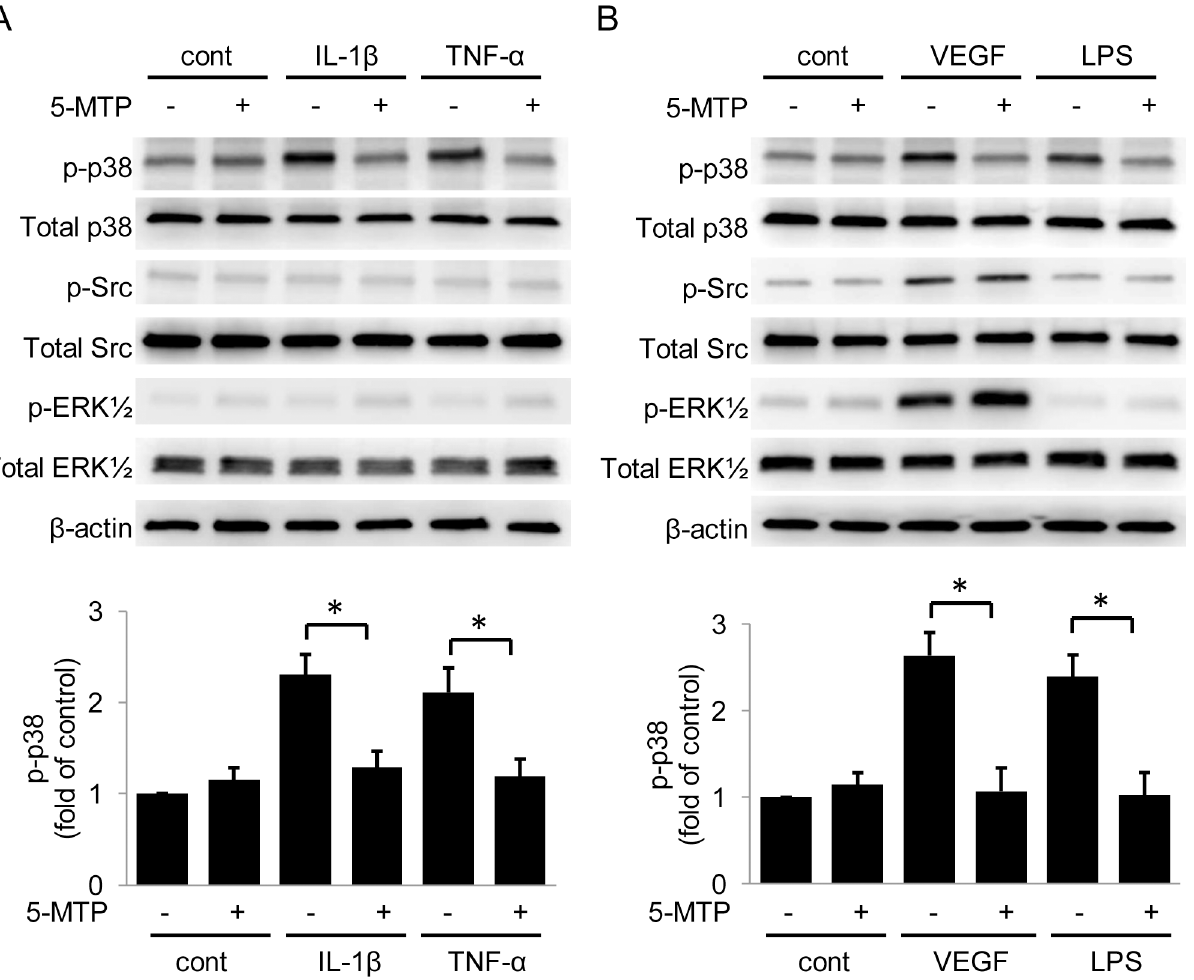
Fig 5. 5-MTP blocks p38 MAPK activation. (A) and (B) Activation of p38, Src and ERK ½ was determined in HUVECs treated with VEGF or pro- inflammatory cytokines. Upper panels show representative blots and lower panels show the densitometry of p-p38 MAPK. Error bars denote mean ± SD (n = 3). * indicates P <